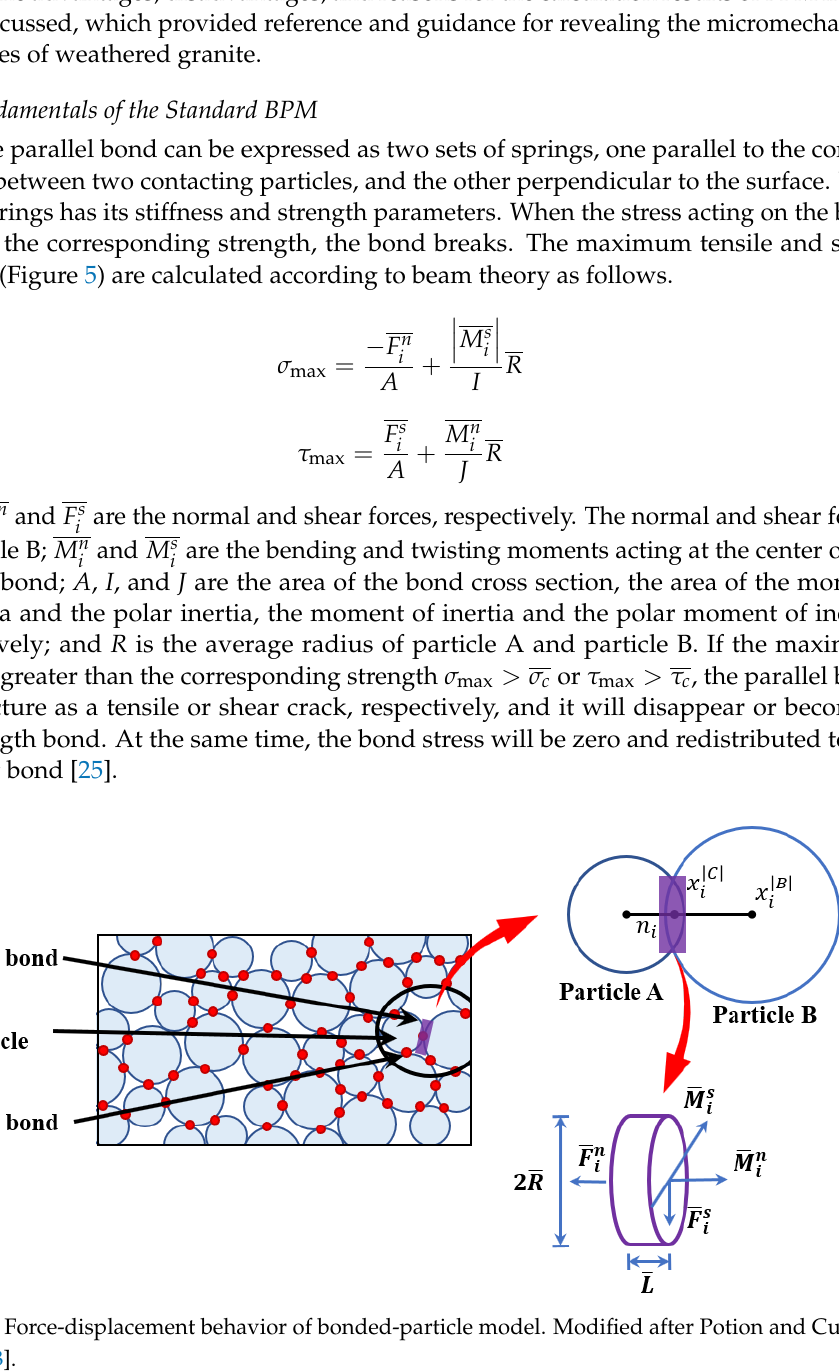
( b ) Figure 6. Calibration of uniaxial stretching parameters, ( a ) Stress strain curve, ( b ) break mode.